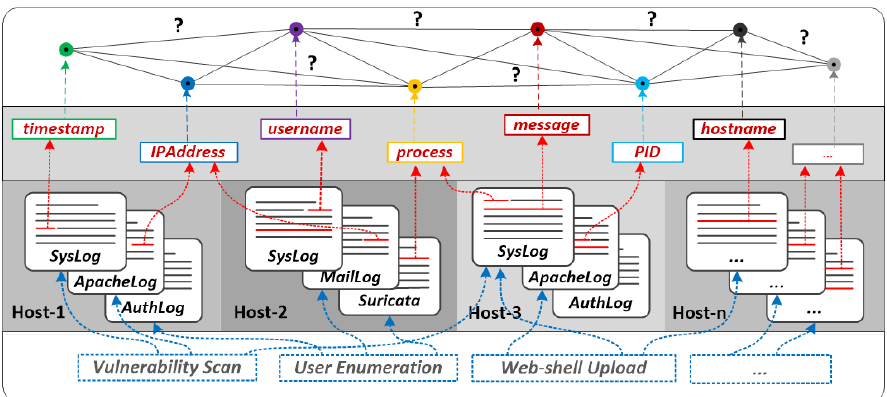
Figure 1. Motivating example illustrating that attack steps leave traces in various log sources across multiple hosts, making it difficult to reconstruct what